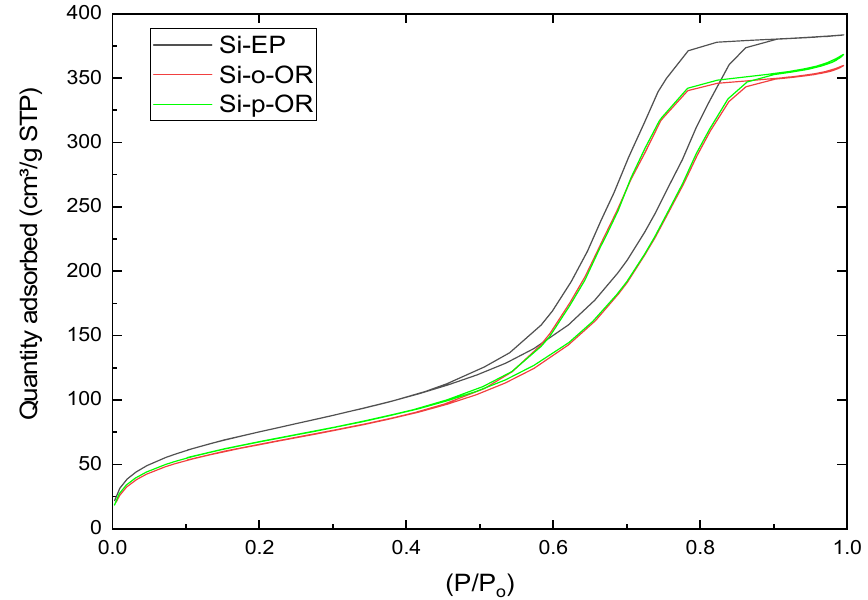
Figure 4. Nitrogen adsorption − desorption isotherm plots of Si-Ep , Si-o-OR and Si-p-OR.